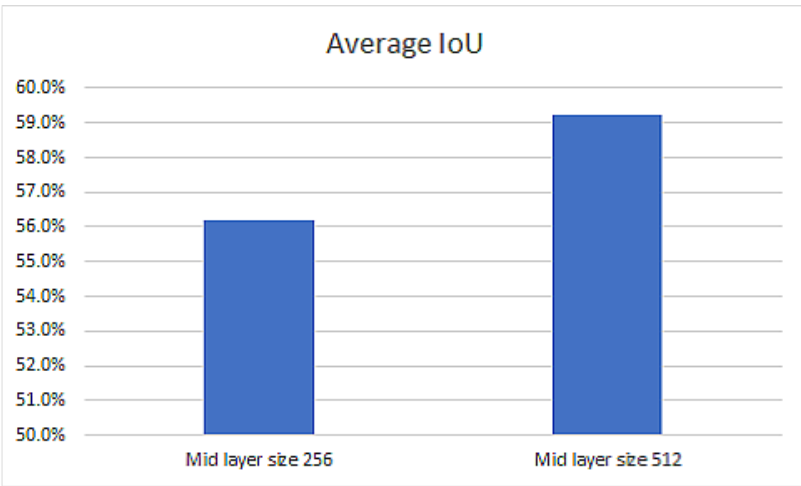
Figure 10. U-NET performance as a function of model size.